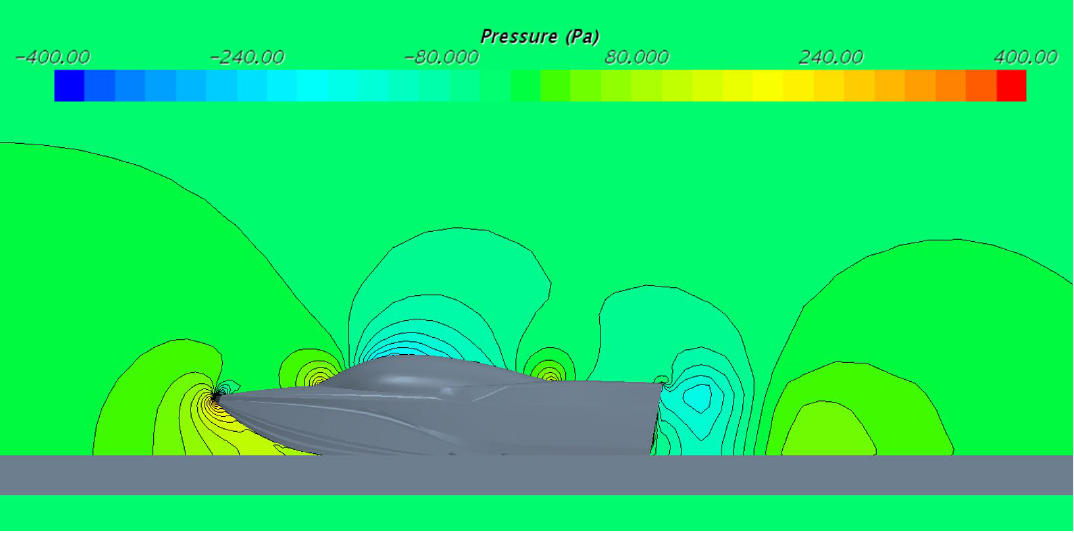
Figure 10. Pressure distribution in middle longitudinal profile of prototype hull at 25 m/s.